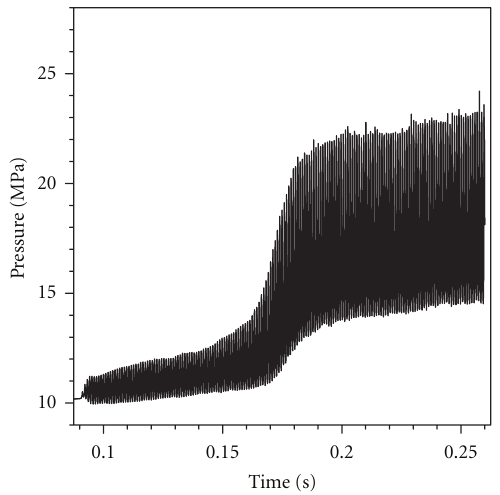
Figure 9: Predicted head-end pressure wave profile, reference motor ( K b = 20000 s − 1 , Δ H s = 150000 J/kg, Δ p d = 2atm,